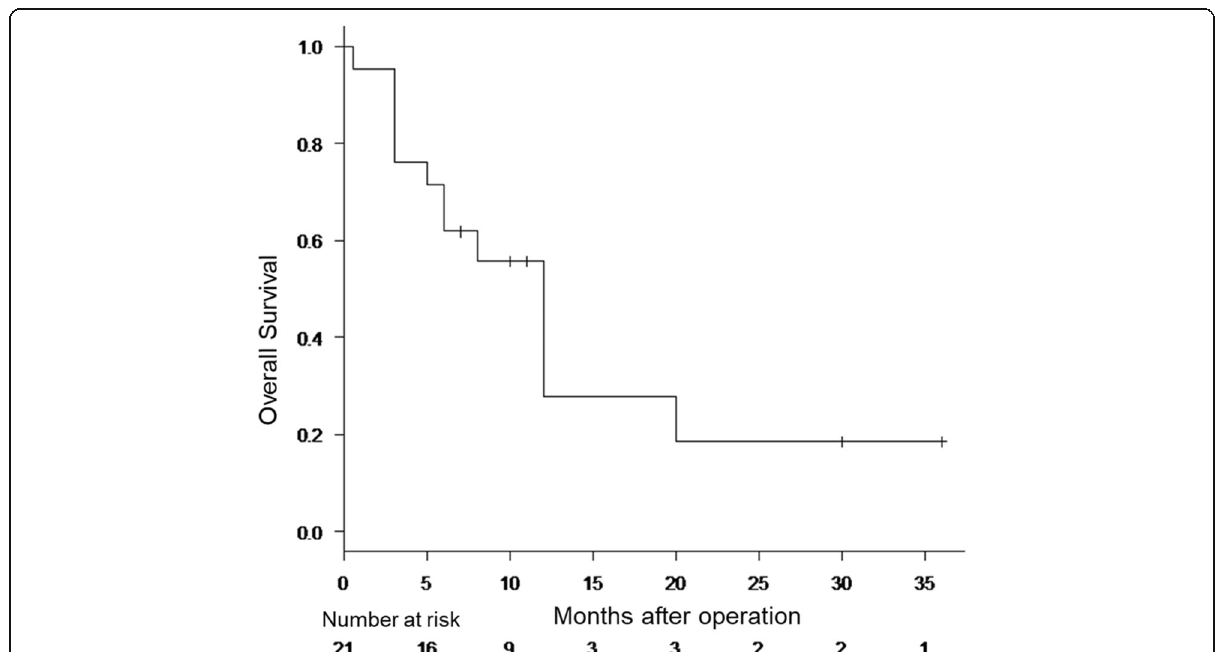
Fig. 6 Survival curves of the 21 resected cases of EHBD NEC. The median OS was 12 months (95% CI, 5 – 20 months), and the 1-year survival rate was